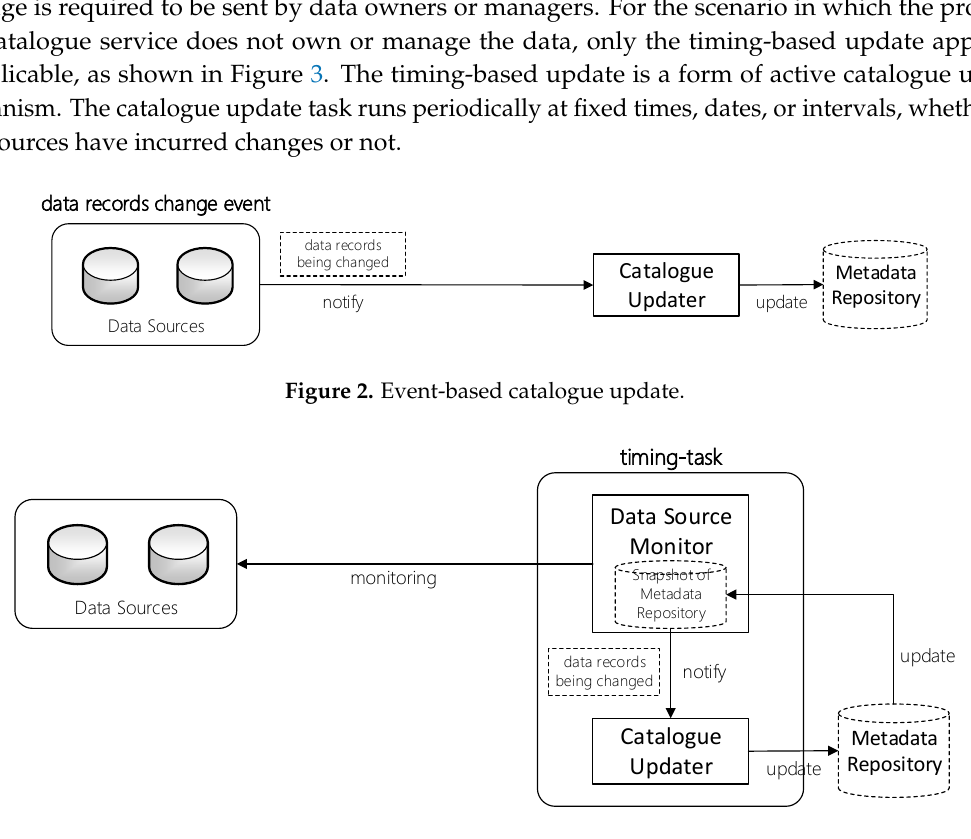
Figure 3. Timing-based catalogue update.